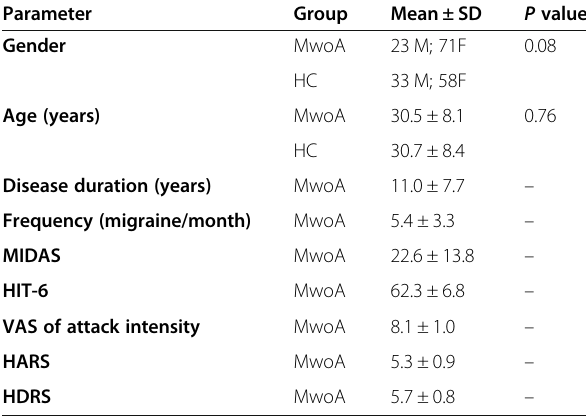
Table 1 Demographic and clinical characteristics of patients with MwoA and HC